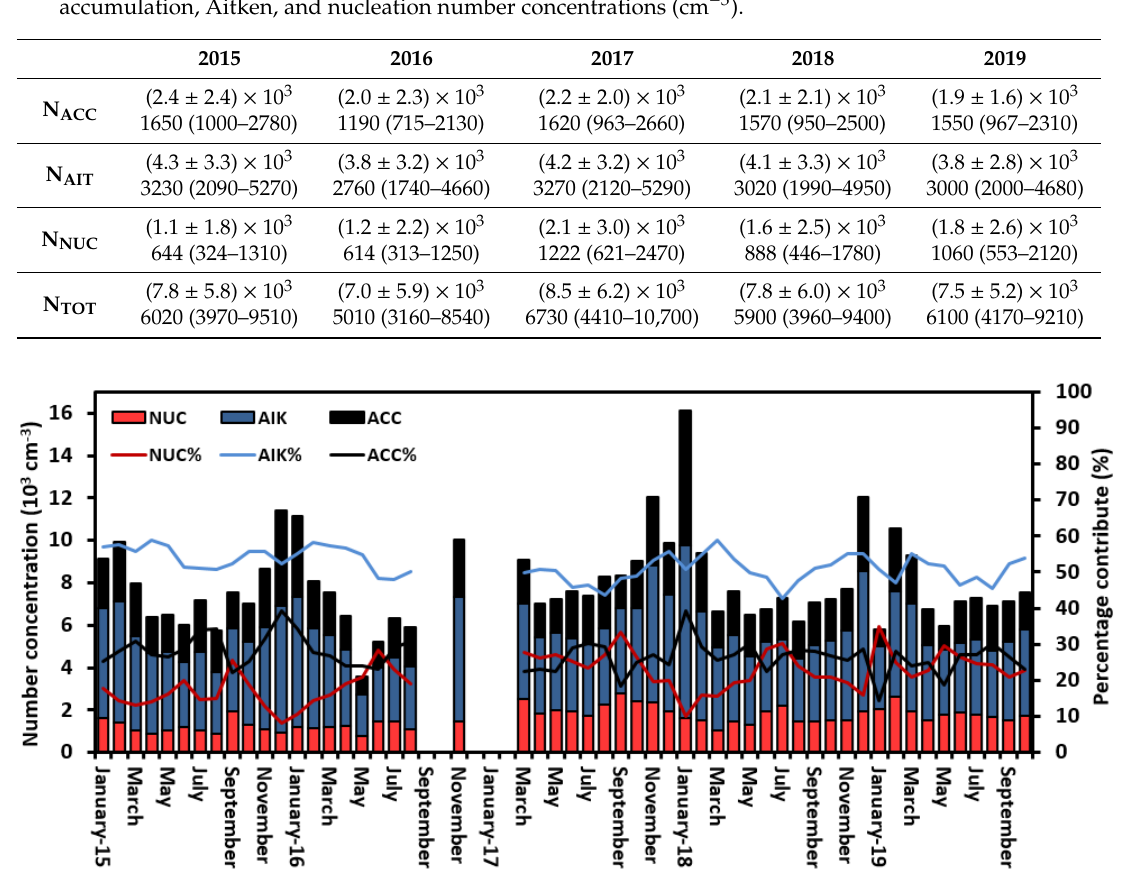
Figure 2. Monthly variation of particle number concentrations for the three size ranges, where the red, blue, and black lines represent the monthly percentage contribution to total particle number concentration of nucleation, Aitken, and accumulation ranges, respectively.